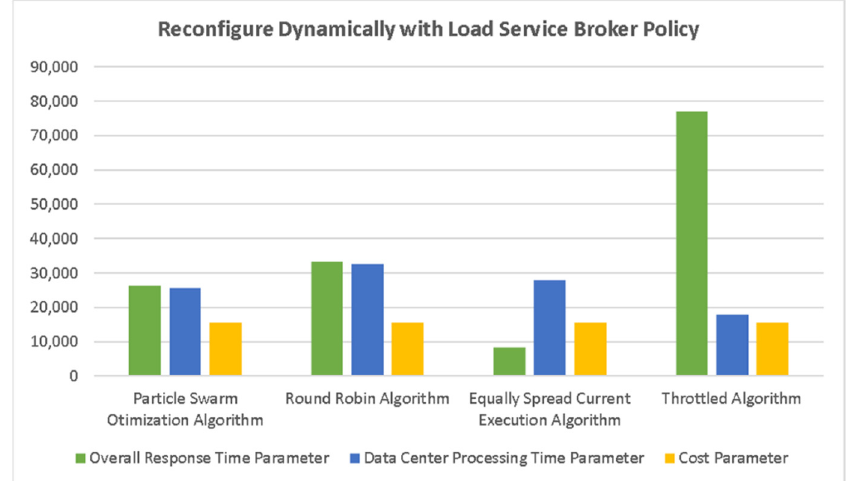
Figure 17. The comparison of PSO, RR, ESCE, and throttled algorithms by considering the parameters based on the reconfiguring dynamically with load SBP.